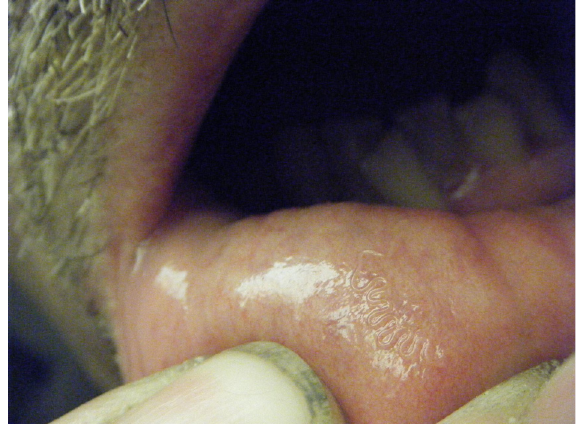
Figure 1. Serpentine path of Gongylonema pulchrum in lip